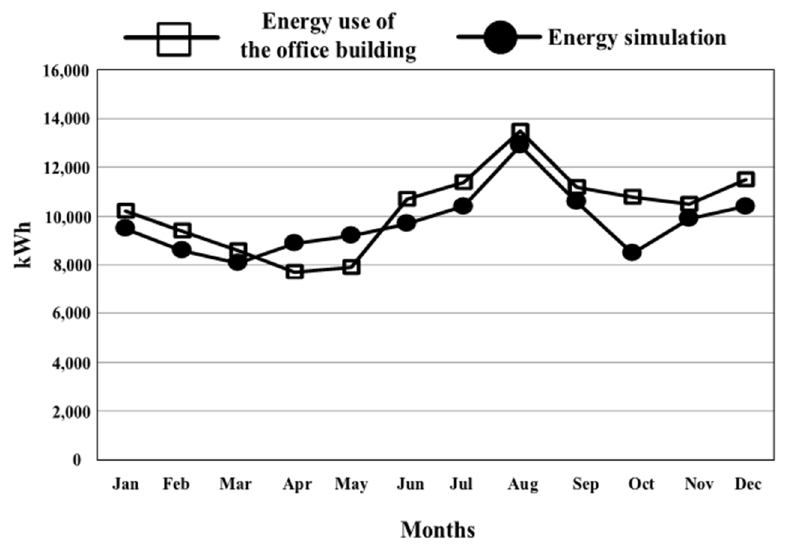
Table 3. Specifications for the window systems.